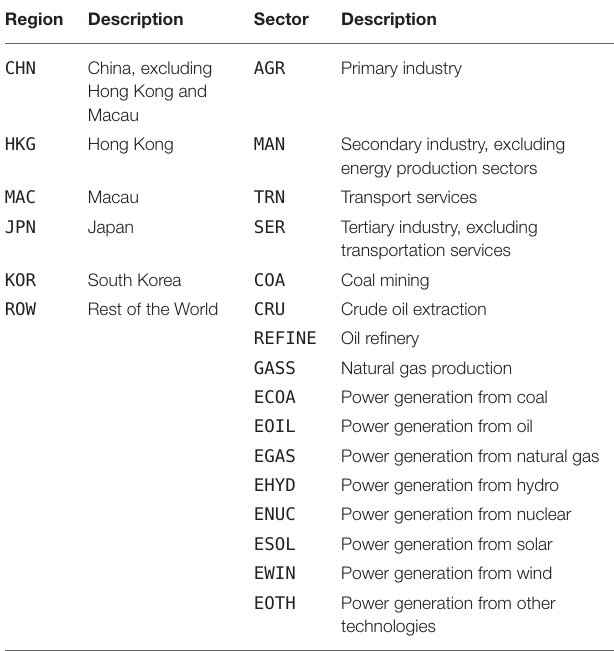
TABLE 2 | Regional and sectoral aggregations in CHEEM. Region